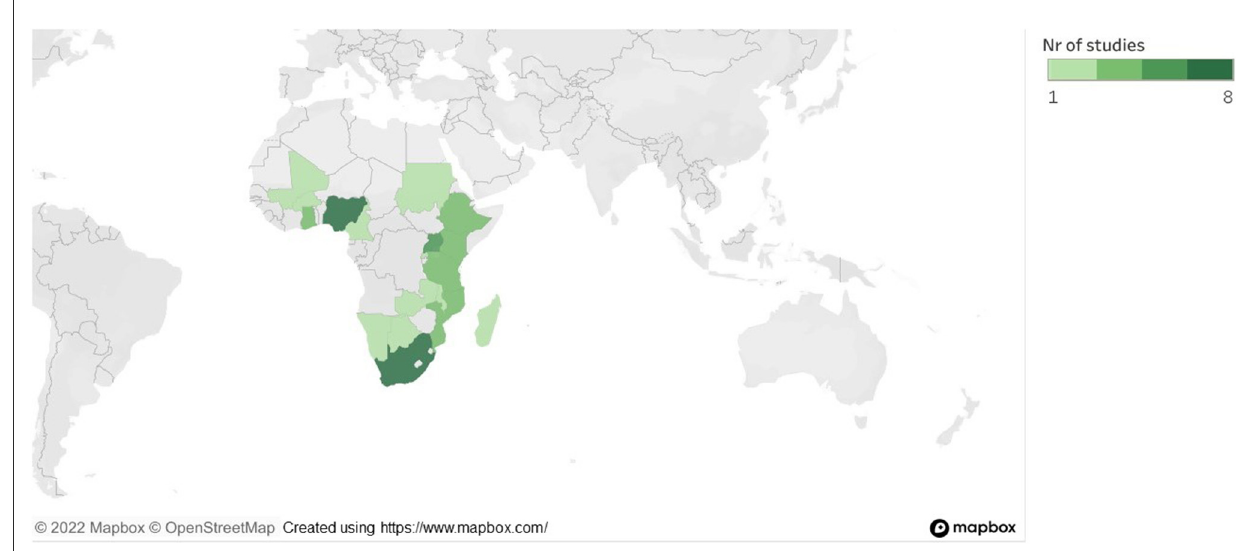
FIGURE2 Geographic distribution of included studies across SSA (series: number of studies). Created using https://www.mapbox.com/.